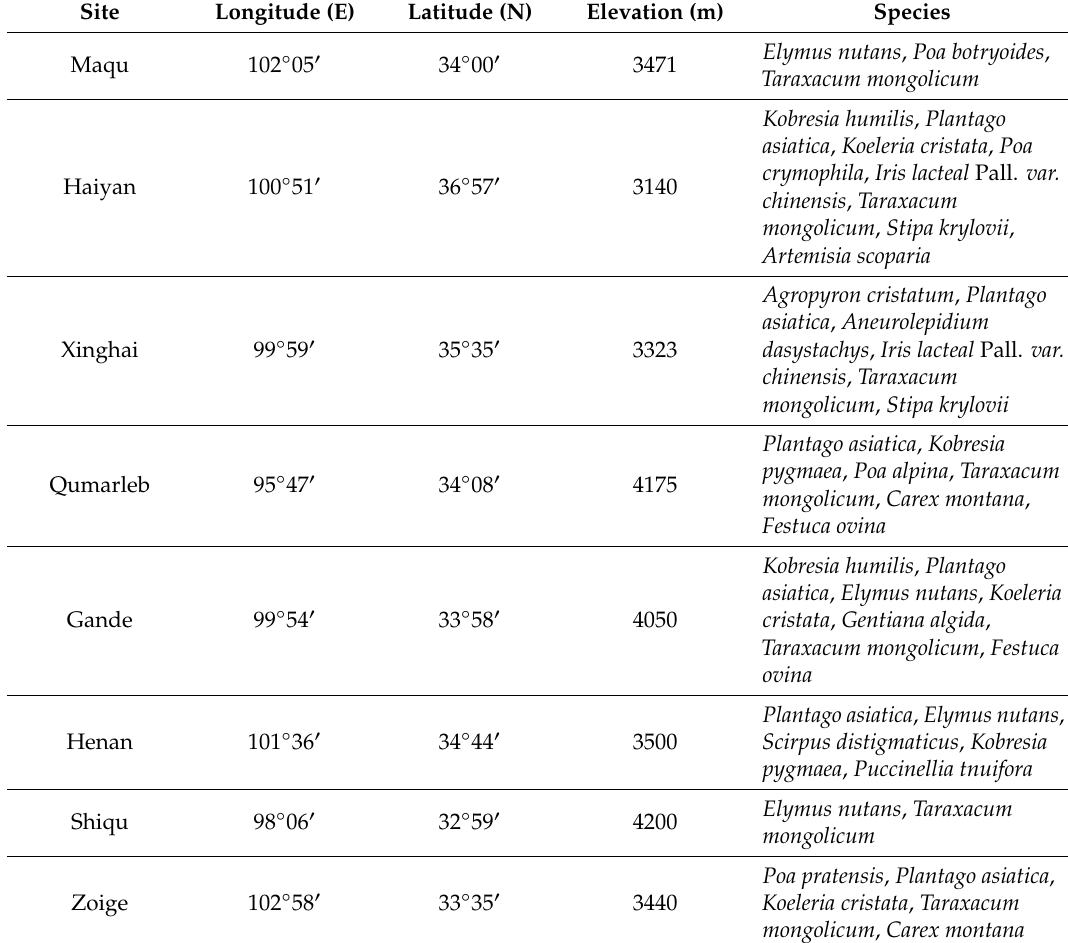
Table 1. Geographical coordinates, elevation, and observed species at each